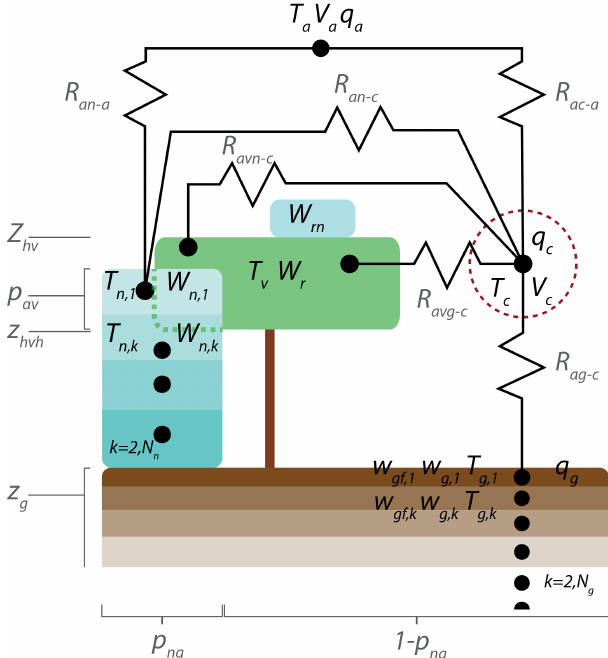
Figure 1. A schematic representation of the turbulent aerodynamic resistance, R a , pathways for ISBA-MEB. The prognostic tempera- ture, liquid water, and liquid water equivalent variables are shown. The canopy air diagnostic variables are enclosed by the red-dashed circle. The ground-based snowpack is indicated using turquoise, the vegetation canopy is shaded green, and ground layers are colored dark brown at the surface, fading to white with depth. Atmospheric variables (lowest atmospheric model or observed reference level) are indicated using the a subscript. The ground snow fraction, p ng , and canopy-snow-cover fraction, p n α , are